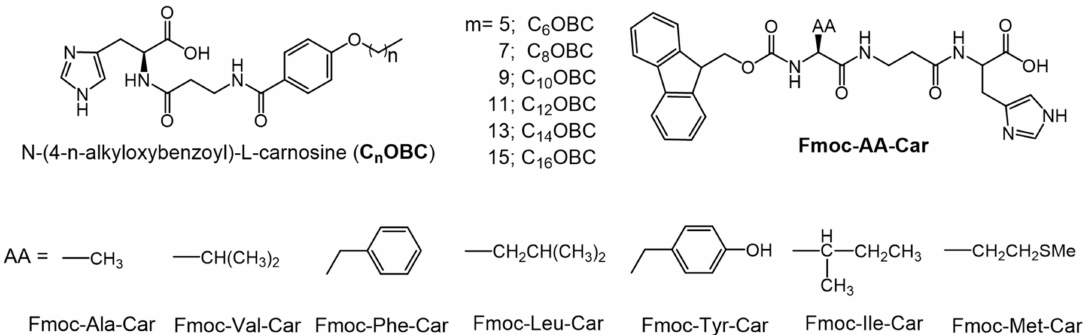
Figure 30. Molecular structure of C n OBC and